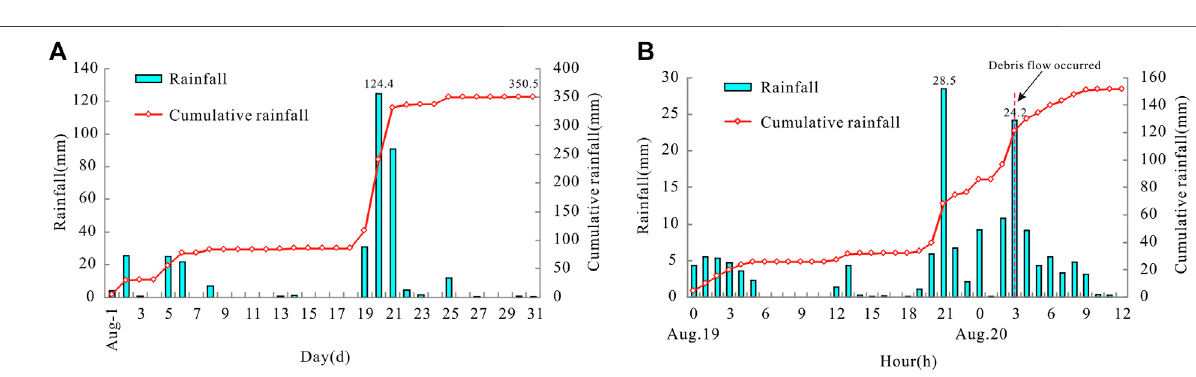
Frontiers in Earth Science |